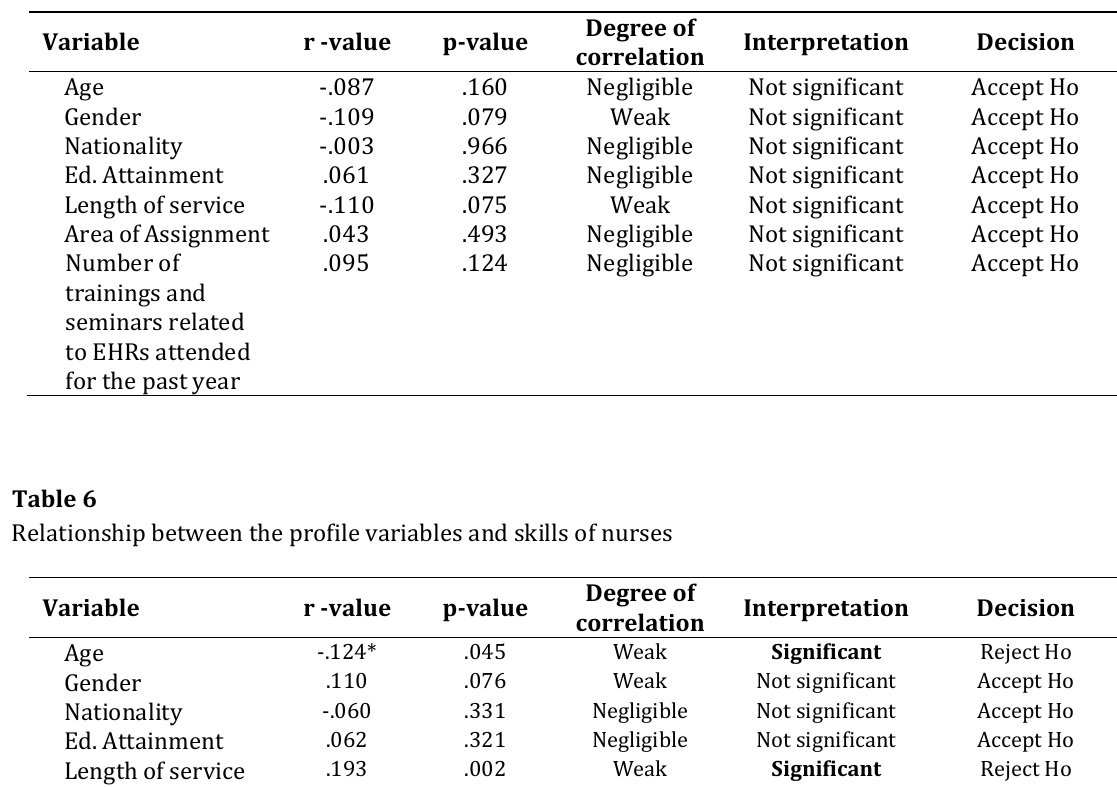
Length of service